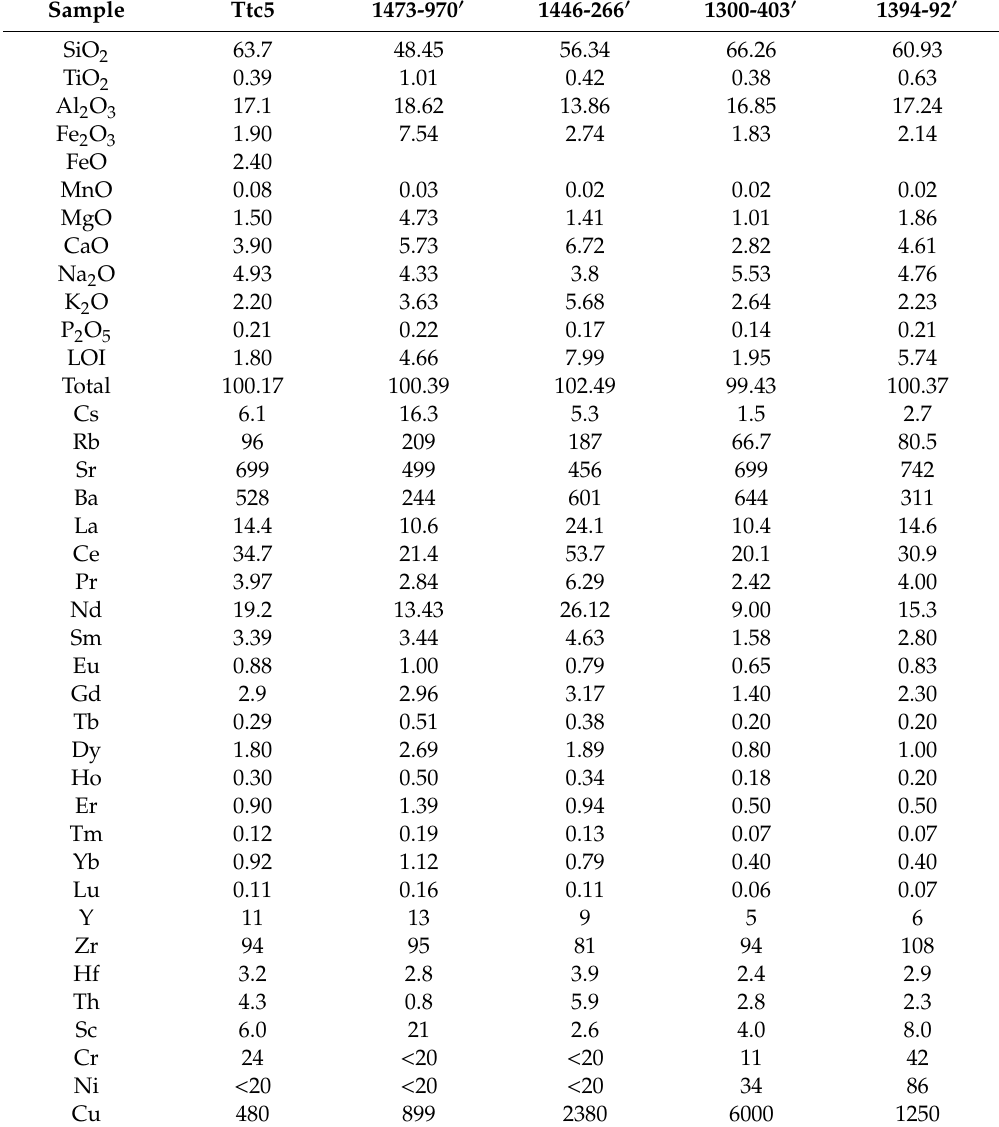
Table 3. Major and trace-element (in ppm) compositions of felsic porphyries